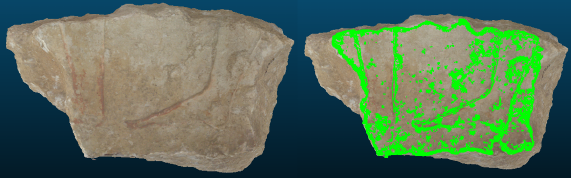
Figure 4: Segmentation of principal